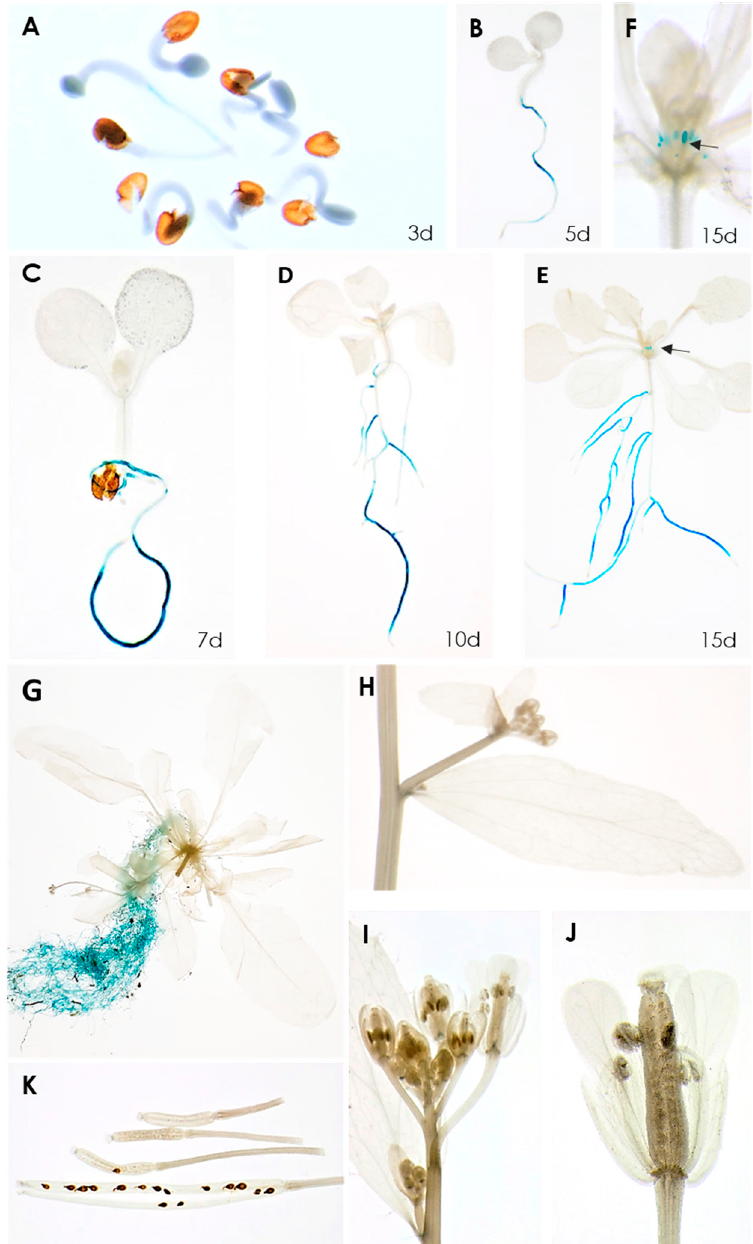
Figure 1. GUS expression in RbohB::GUS transgenic line. ( A – E ), seedlings grown on MS medium for 3, 5, 7, 10, 15 days. GUS expression is only visible in roots, except for 15-day-old seedling shown in ( E ). ( F ), Enlargement of 15-day-old seedling showing GUS expression in leaf primordia. ( G – K ), plants grown on soil in long day. ( G ), 6-week-old plant showing GUS expression in roots. No GUS expression was found in cauline leaves ( H ), flowers ( I , J ) or siliques and seeds ( K ). Arrows in ( E , F ) point to leaf